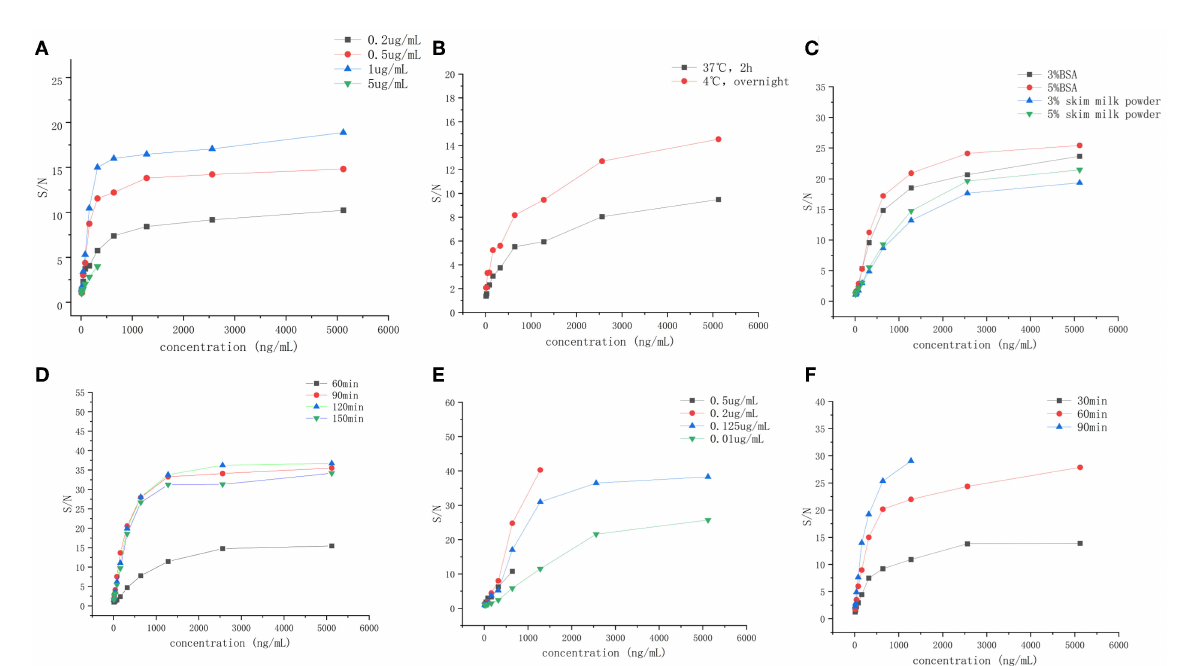
FIGURE1 The establishment and optimization ELISA method of the recombinant canine PD-1 fusion protein. (A) The concentration of capture antibody (0.2, 0.5, 1, and 5 µ g/ml. (B) The coating condition (under 37 ◦ C for 2h, under 4 ◦ C overnight). (C) The blocking solution (3% BSA, 5% BSA, 3% skim milk powder, and 5% skim milk powder). (D) The blocking time (60, 90, 120, and 150min). (E) The concentration of detection antibody (0.5, 0.2, 0.125, and 0.1 µ g/ml). (F) Incubation time of detection antibody (30, 60, and